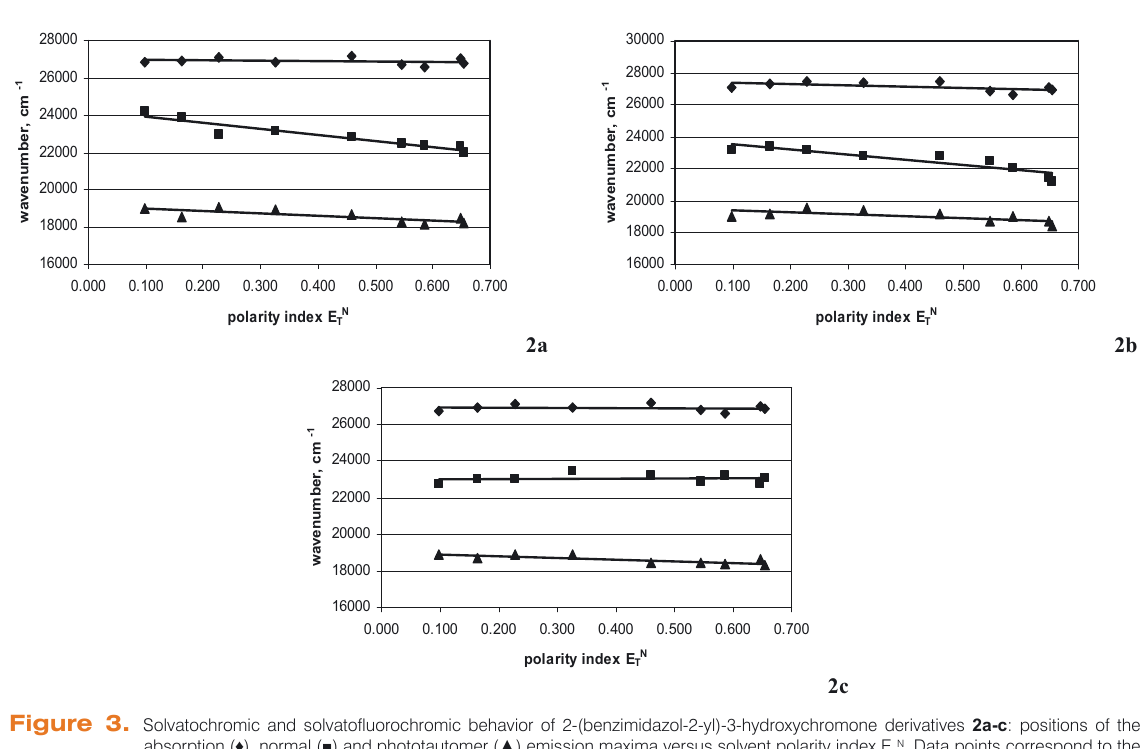
N . Data points correspond to the T